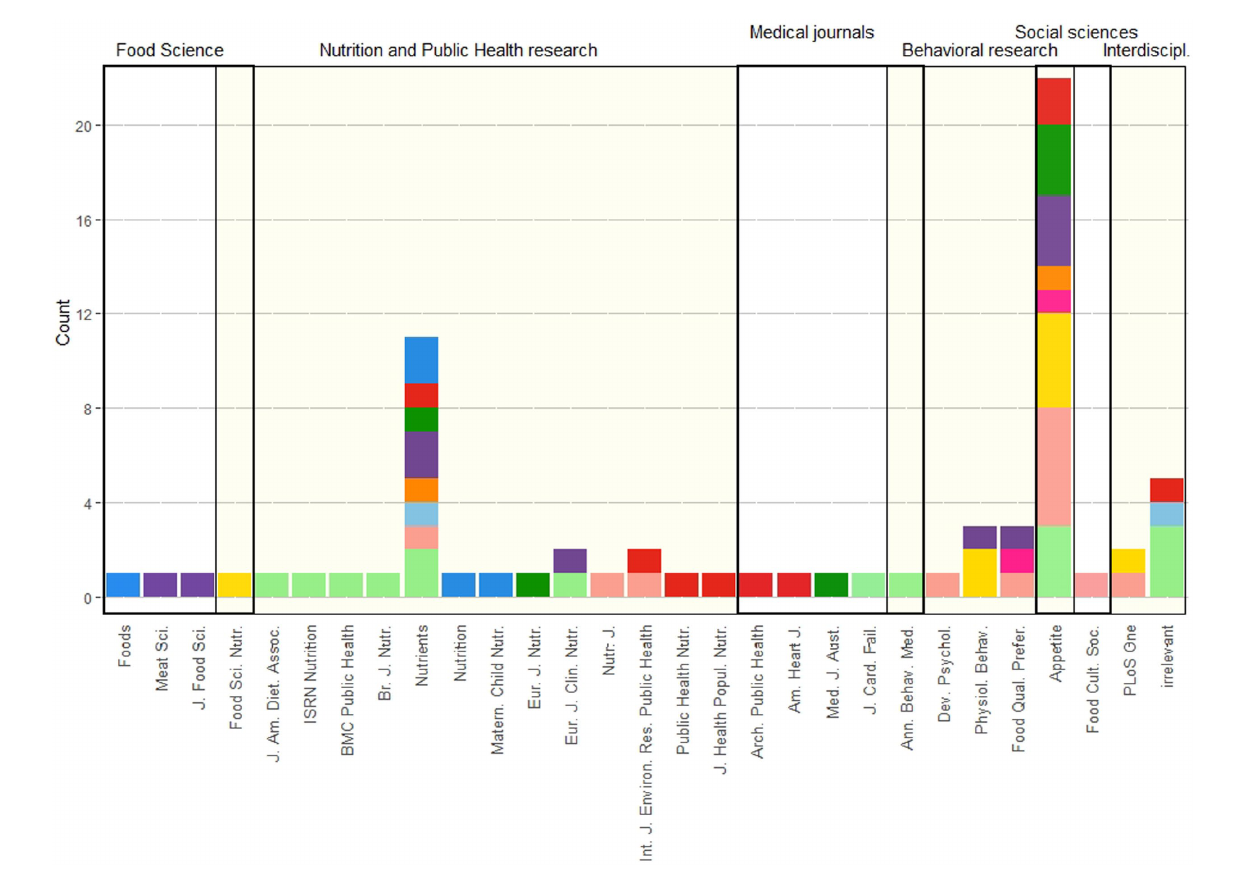
FIGURE 1 Stacked bar chart of research